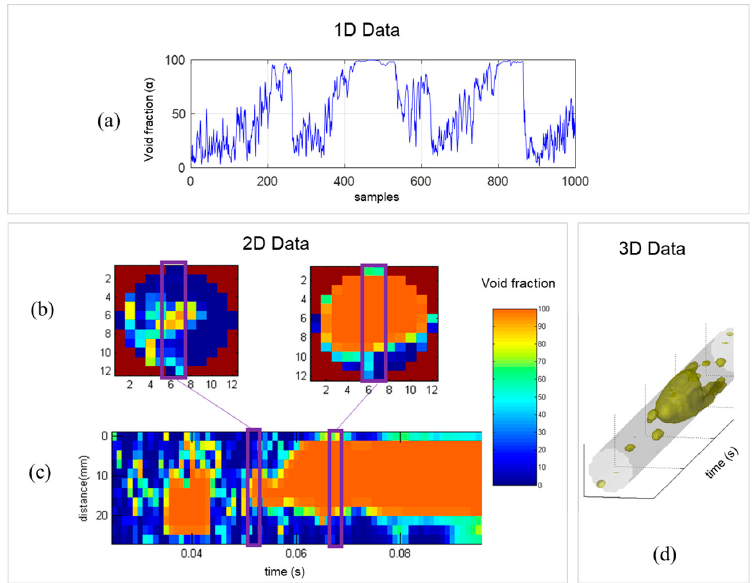
Figure 5. Signal processing of water/gas slug flow acquired with the wire-mesh sensor: ( a ) Averaged void fraction time series, ( b ) cross-sectional and ( c ) axial cut slice images, and ( d ) three-dimensional isosurface plot to view the gas-phase